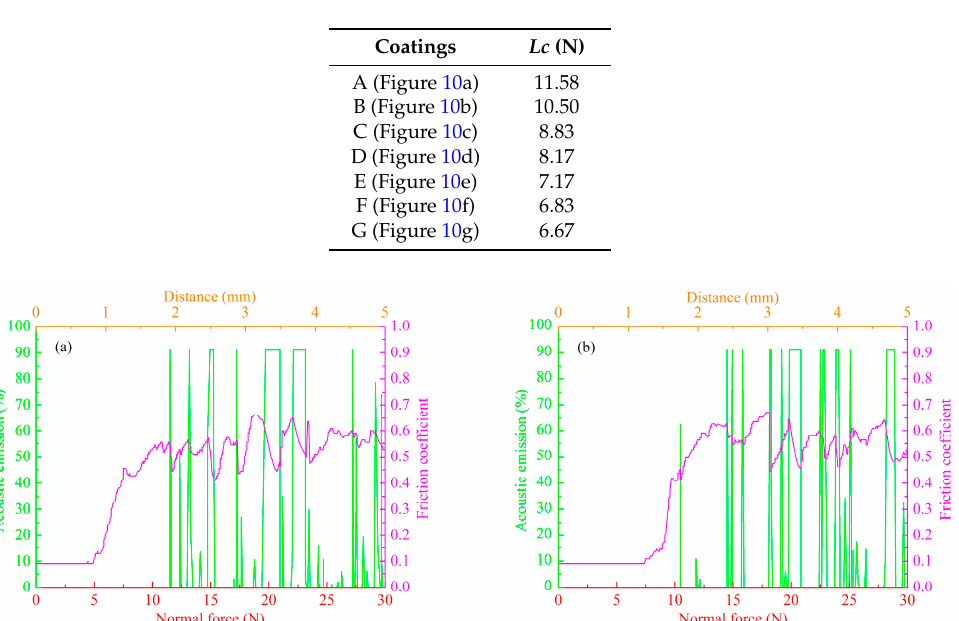
Figure 10. The scanning electron microscope (SEM) morphologies of scratches on the microarc oxidation coatings formed on aluminum alloys at different anode pulse-widths. ( a ) 1000 μ s; ( b ) 1500 μ s; ( c ) 2000 μ s; ( d ) 2500 μ s; ( e ) 3000 μ s; ( f ) 3500 μ s; ( g ) 4000 μ s. Table 3. Critical load values of MAO coatings formed on aluminum alloys at different anode pulse-widths.